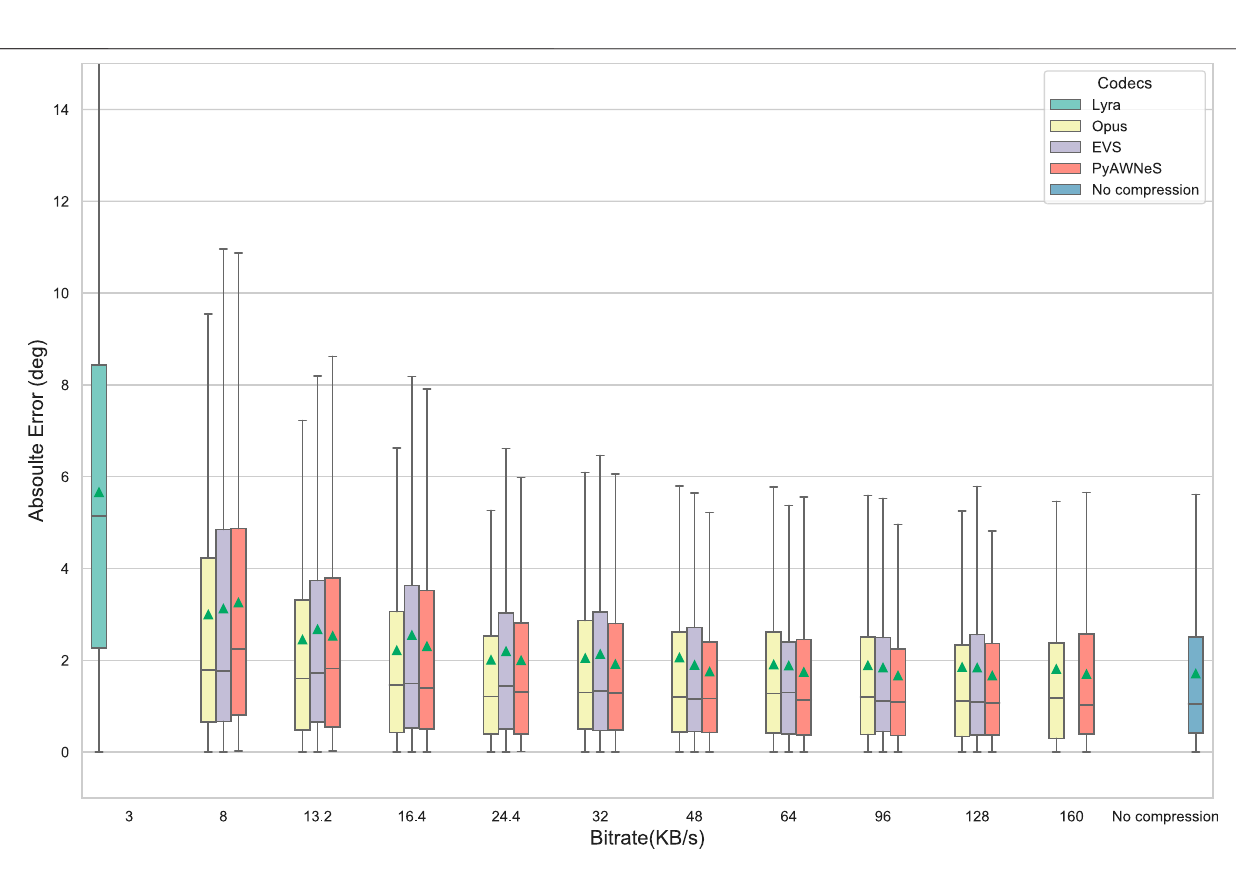
Frontiers in Signal Processing |